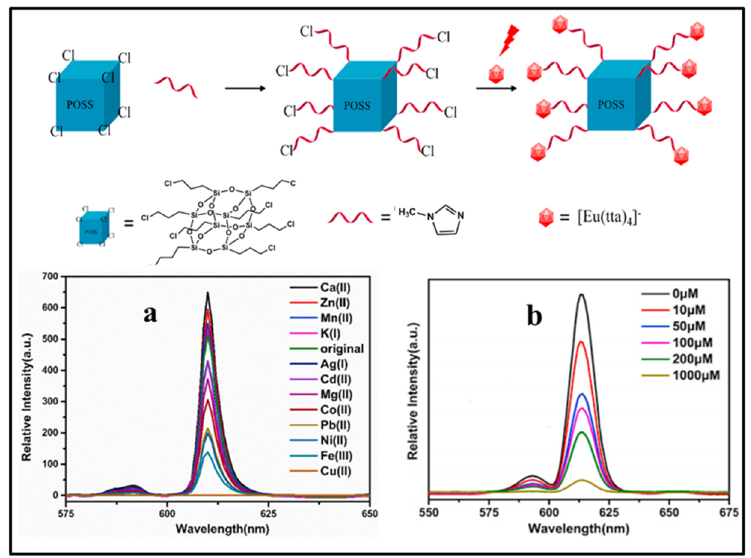
Figure 12. Synthetic procedure of POSS-min- [Eu(tta) 4 ]. The PL spectra of POSS-min- [Eu(tta) 4 ] to different aqueous solution of metal cations ( a ) and to different concentration aqueous solution of Cu 2+ ( b ) [90].